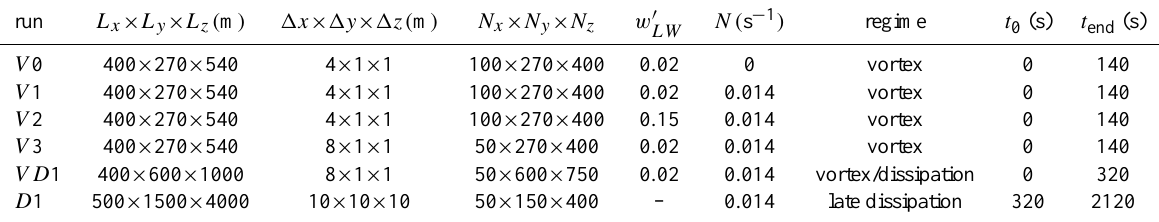
Table 1. List of parameters of the numerical simulations: computational domain ( L x × L y × L z ); resolution ( 1x × 1y × 1z ); number of grid points ( N x × N y × N z ); initial vortex perturbation ( w 0 ); Brunt-V¨ais¨al¨a frequency ( N ); wake regime; start and end time of the run ( t 0 and LW t end